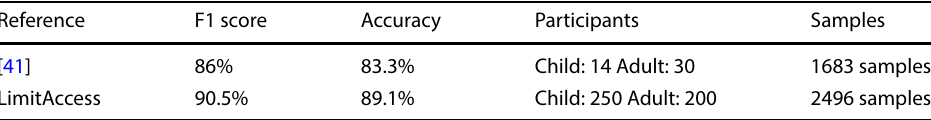
Table 6 Comparison between the baseline and